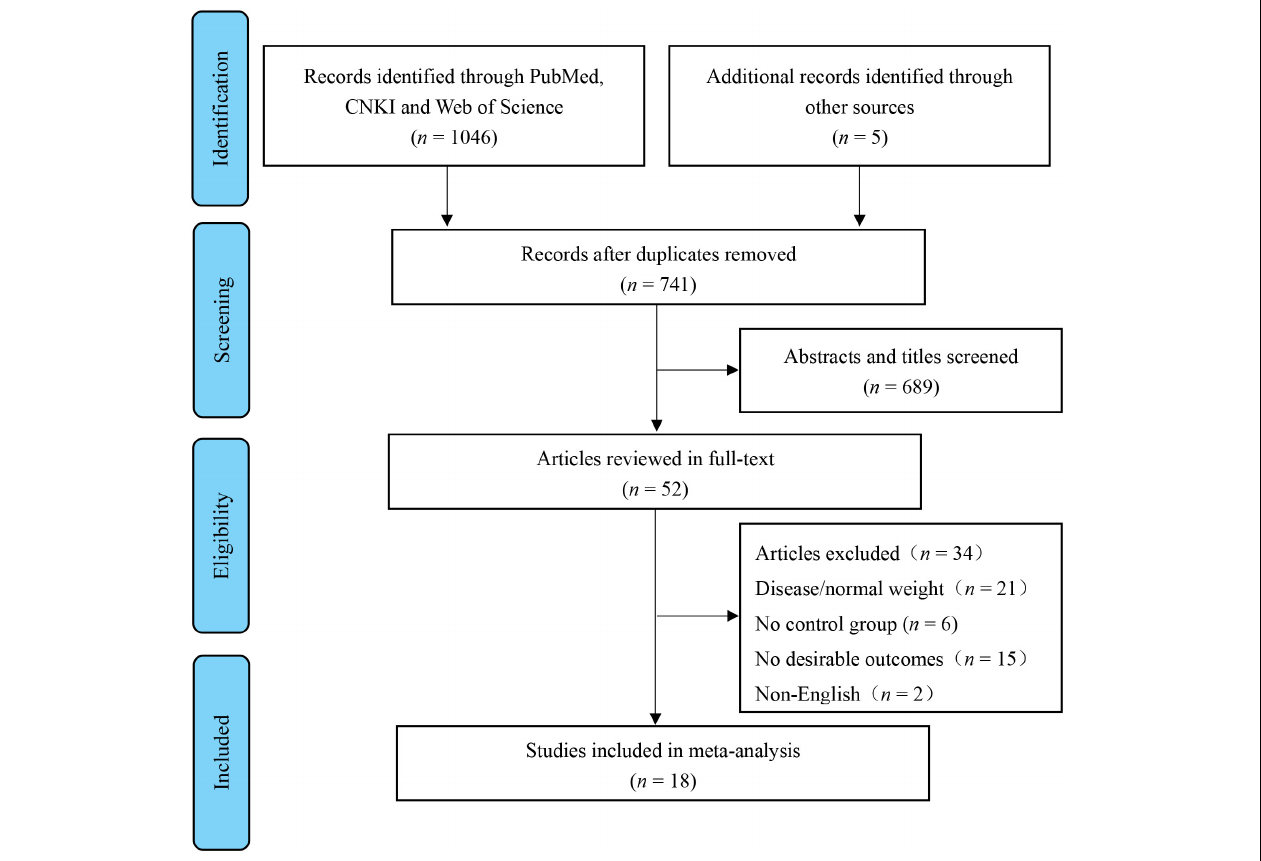
FIGURE 1 | Flow diagram of study